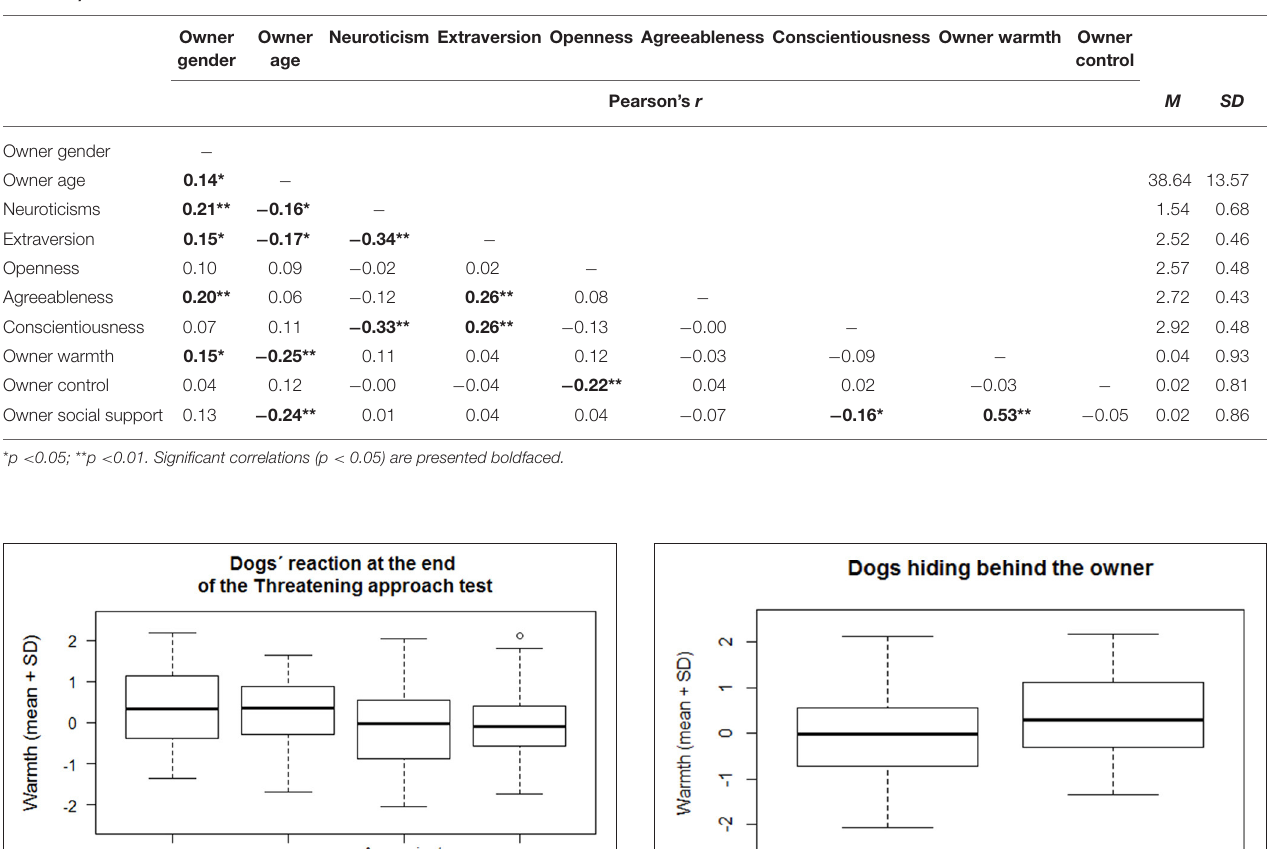
TABLE 4 | Correlations between Owner interaction styles, owner demographic characteristics and owner personality factors (Pearson’s r and descriptive statistics).